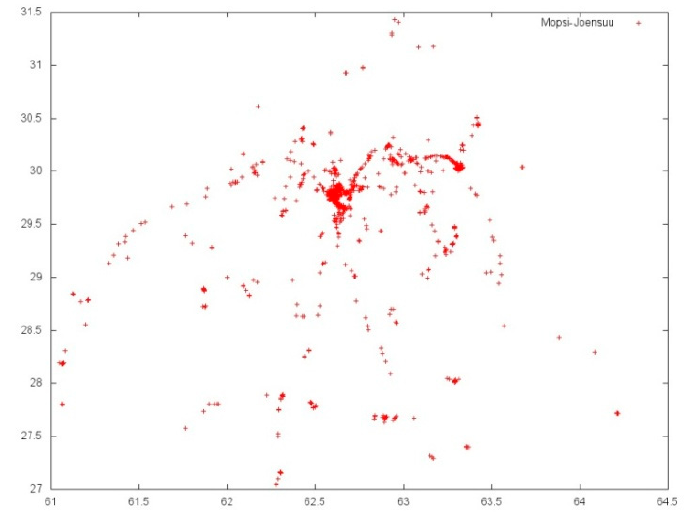
Figure 4. Mopsi-Joensuu data set visualization.